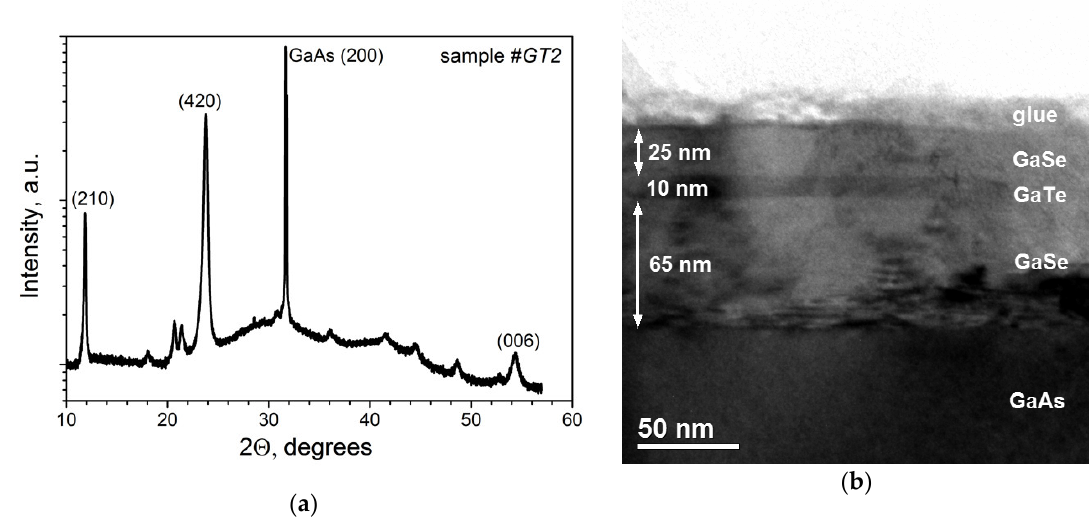
Figure 18. ( a ) The X-ray powder diffraction pattern of GaTe layer grown at T S ≈ 530 °C (# GT2 ); ( b ) cross-section TEM image of the GaSe/GaTe/GaSe heterostructure.